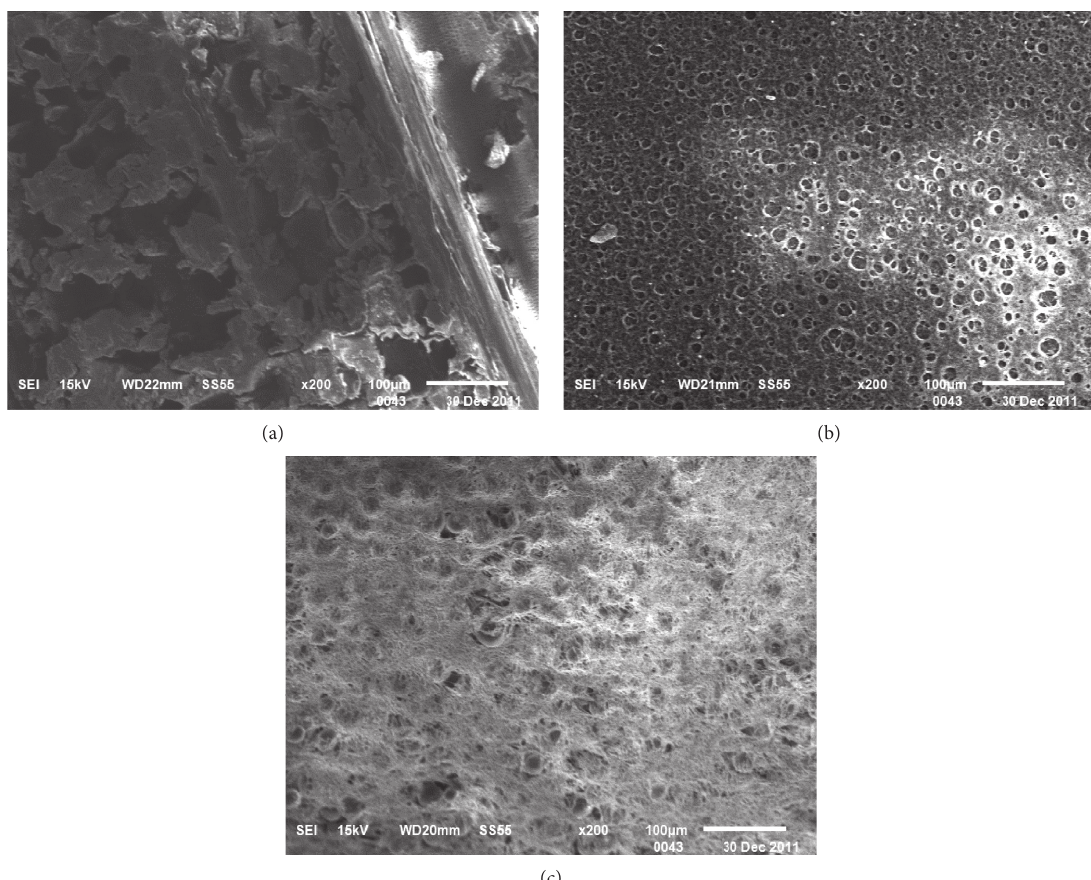
Figure 2: Scanning electron microscopy images of (a) wooden tip, (b) PAN-coated wooden tip, and (c) PAN/HLB-coated wooden tip.